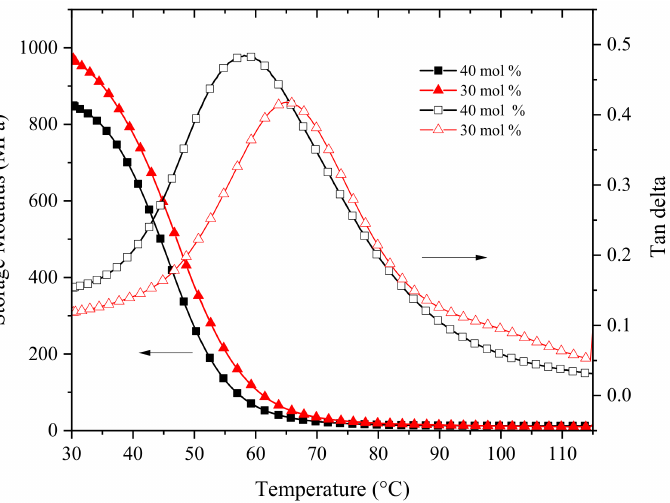
Figure 6. Results of DMA analysis of the polymers obtained by photopolymerizing ETE formulations with 40 mol % and 30 mol % of